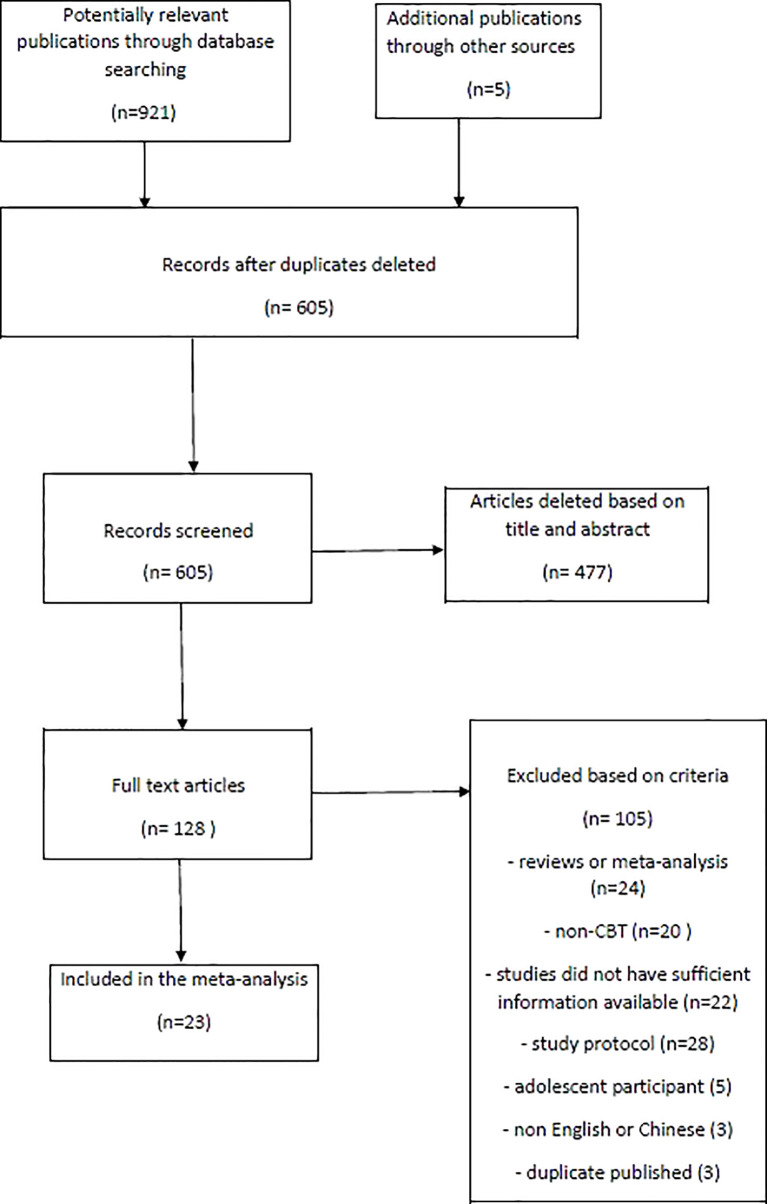
PRISMA flow diagram.